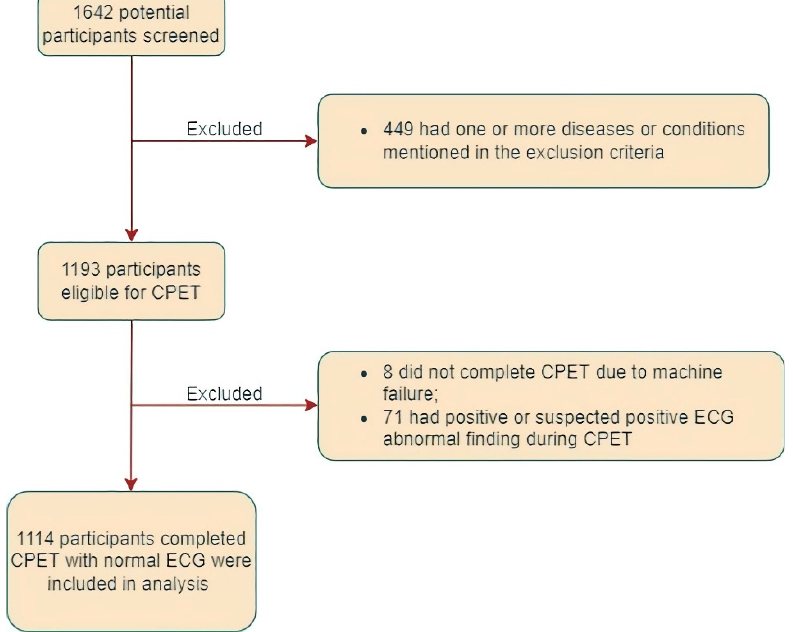
Figure 1. The flowchart for inclusion and exclusion of participants in the study. Table 1. demographic characteristics in the Chinese adult population.